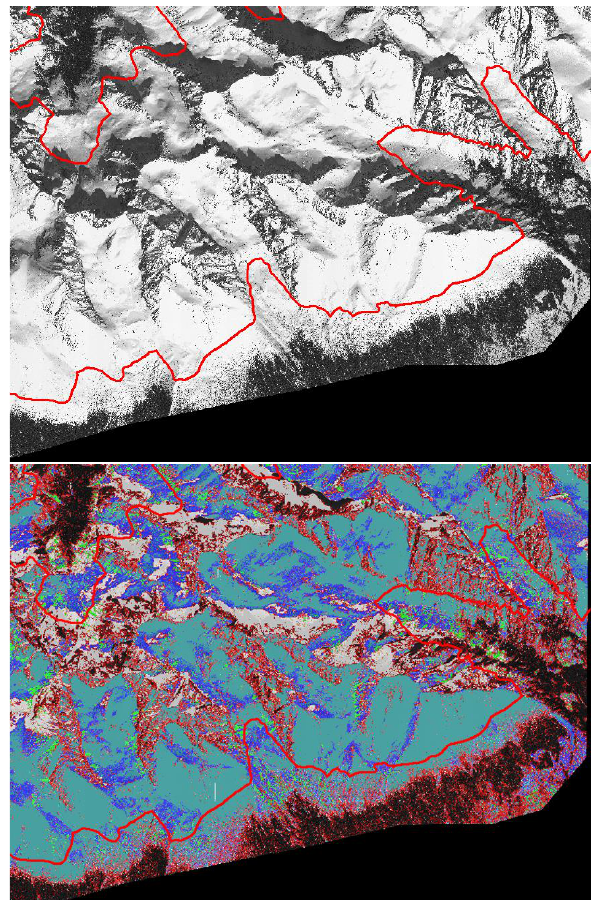
Figure 6: Automatic avalanche detection for the entire Slovakian training area. Top) raw image; bottom) green = avalanche debris; turquoise = glare and non-avalanche snow without rake pattern; blue = rake pattern; red = rock outcrops and forested areas; red line = 1700 m a.s.l. contour line which approximately delineates the height below which the "rake pattern" problem starts occurring in this data set. (Satellite image: Copyright © DigitalGlobe/WorldView-1).